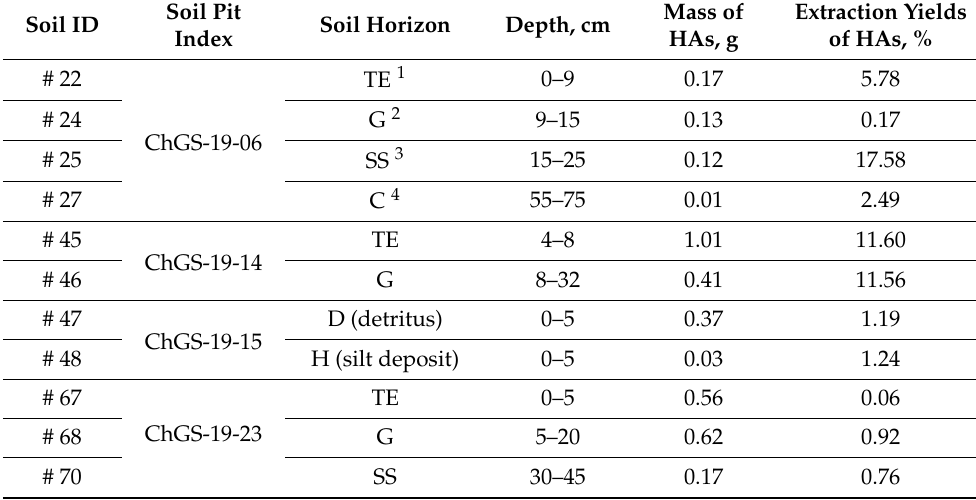
Table 1. The basic information about HAs